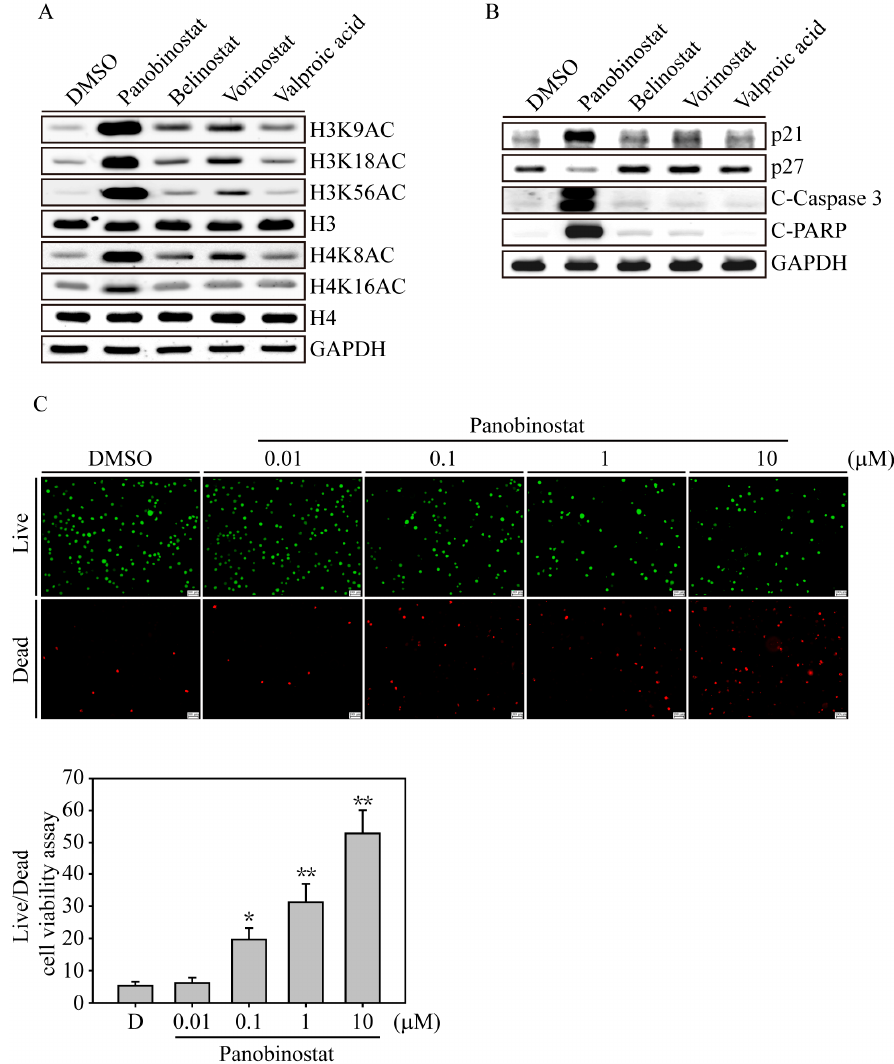
Figure 3. HDACi induced histone acetylation, cell cycle arrest and apoptosis-related protein expression. ( A ) K562 cells were treated with 1 μ M HDACi for 6 h, and the cell lysates were immunoblotted with different H3 (H3K9AC, H3K18AC and H3K56AC) and H4 (H4K8AC and H4K16AC) histone acetylation antibodies. H3, H4 and glyceraldehyde-3-phosphate dehydrogenase (GAPDH) immunoblots served as internal controls. ( B ) K562 cell lysates treated with 1 μ M HDACi 166 for 24 h were examined for cell cycle (p21 and p27) and apoptotic-related protein (C-Caspase 3: cleaved Caspase 3 and C-PARP: cleaved PARP) expression. GAPDH immunoblotting served as an internal control. ( C ) Live/Dead cell viability assays. Fluorescence images of K562 cells exposed to different concentrations of panobinostat (0.01 to 10 μ M) for 24 h. The cells were costained with 1 μ M 170 calcein-AM/10 μ M PI and excited with light at 488 nm (green emission) to show viable cells. The 171 same image of the cells also excited with 532 nm light (red emission) to show the dead cells. The scale 172 bar on the right-bottom corner indicates 100 μ M. Data are presented as the mean and standard 173